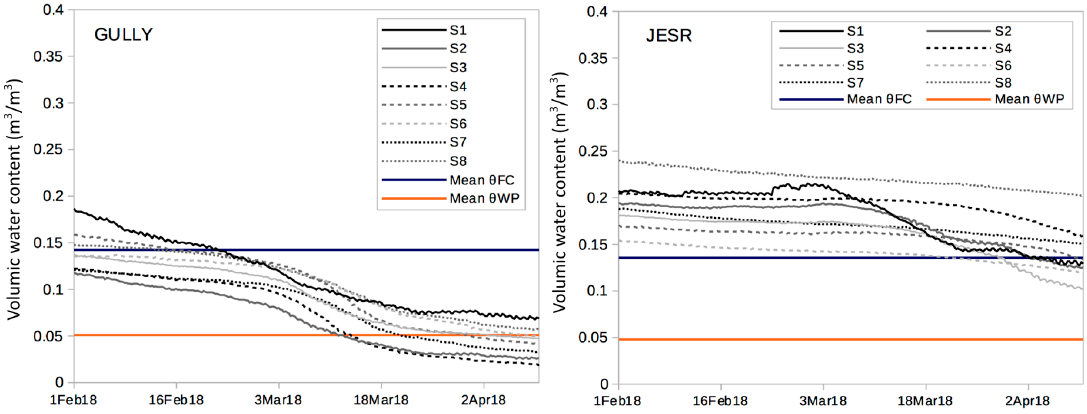
Figure 7. Evolution of soil moisture at different depths (eight sensors) in the gully and the Jesr during the soil drying period (February–April 2018).